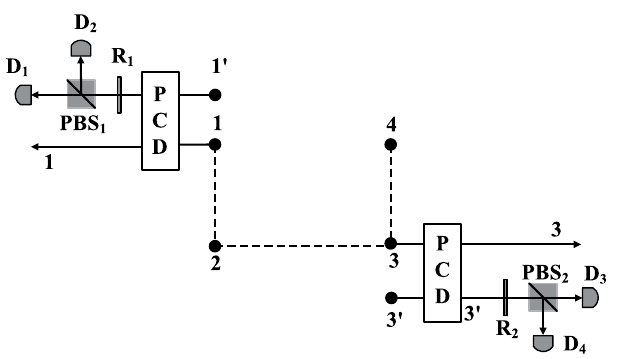
Figure 2. Schematic drawing of ECP for a four-particle cluster state with ancillary particles. PCD means the “parity checking device” which distinguishes the parity between particle i and ancillary particle i ′ using cross- Kerr nonlinearity. PBS i represents a polarizing beam splitter, which transmits the particle in the horizontal polarization | H 〉 and reflects the particle in the vertical polarization | V 〉 . R i represents a wave plate which represents a Hadamard operation on the ancillary single